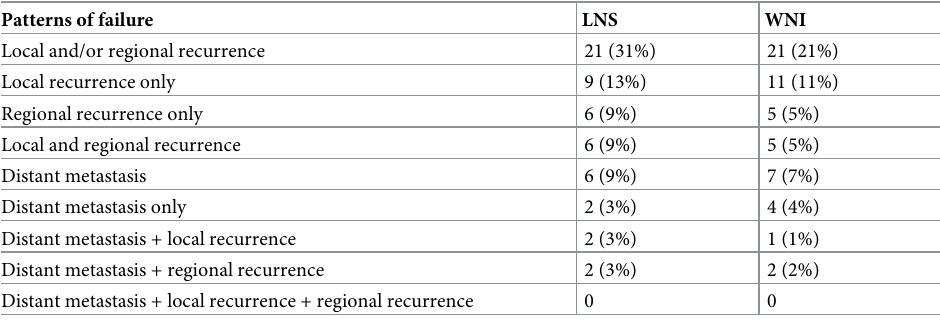
Table 3. Patterns of failure.